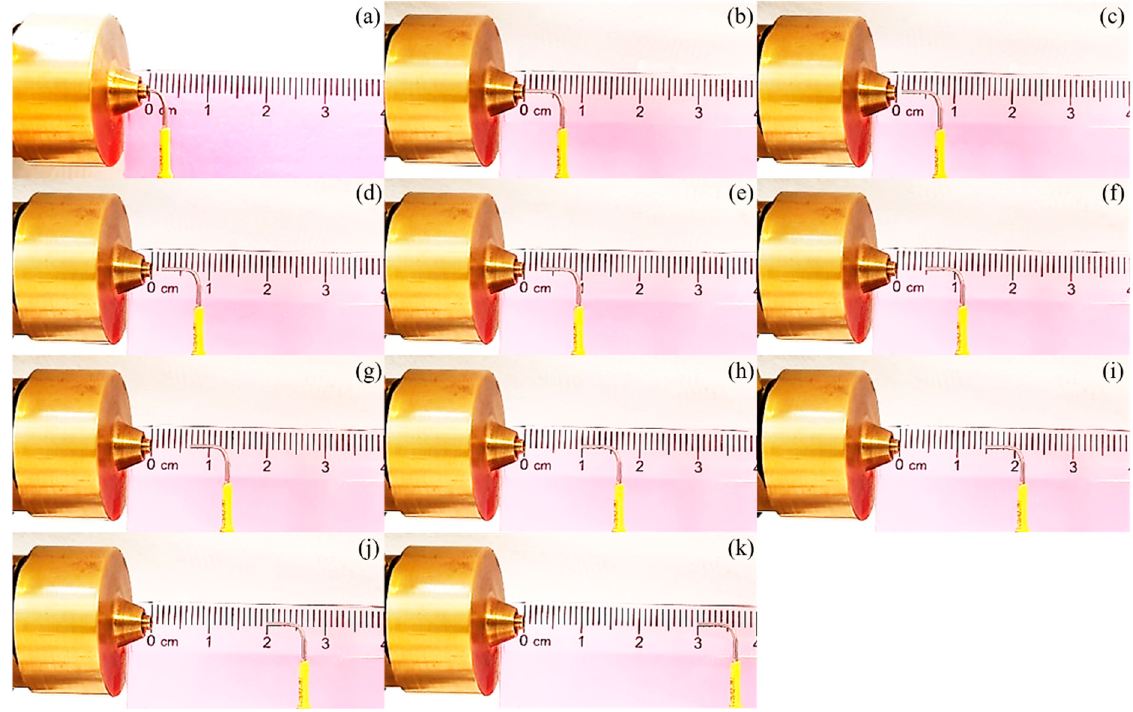
Figure 3. Varying distance between pitot tube and the nozzle outlet: ( a ) − 5 mm (negative sign shows that the pitot tube is inside the nozzle), ( b ) 0 mm, ( c ) 1 mm, ( d ) 2 mm, ( e ) 3 mm, ( f ) 5 mm, ( g ) 7 mm, ( h ) 10 mm, ( i ) 15 mm, ( j ) 20 mm, and ( k ) 30 mm.